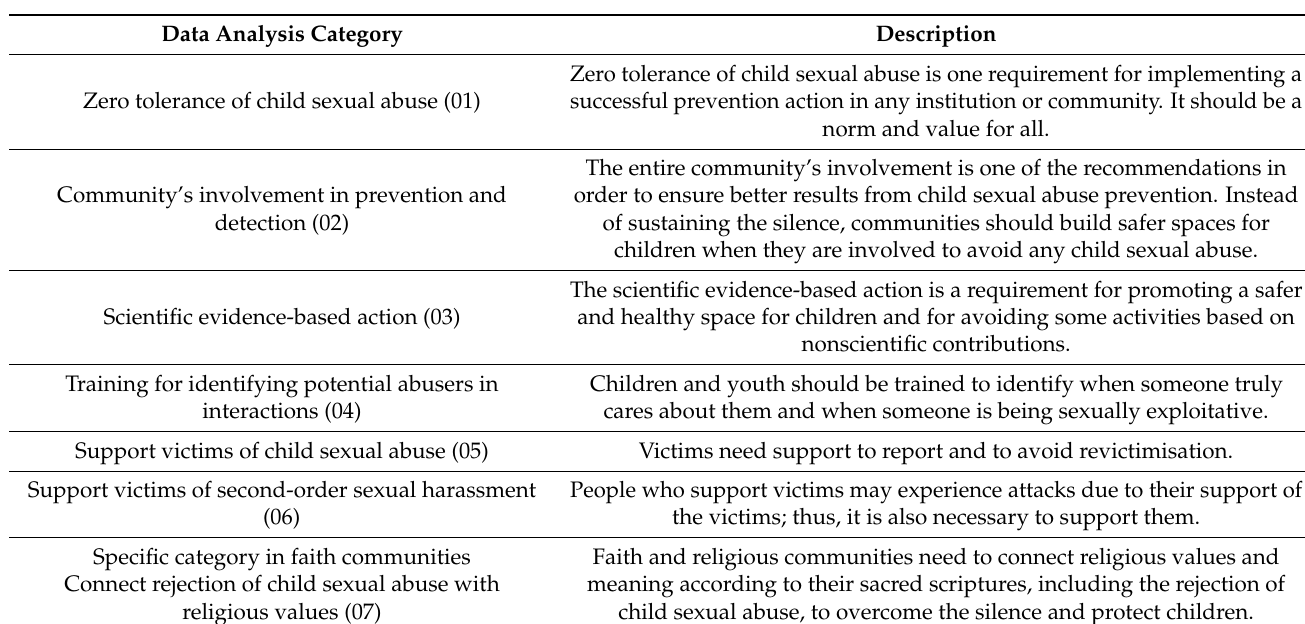
Table 2. Data analysis